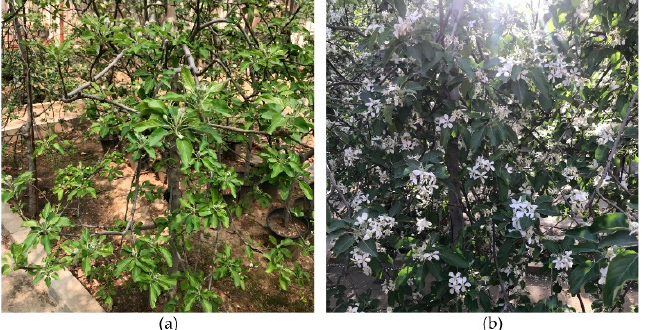
Figure 5. Images of apple flowers in complex natural environments. ( a ) Unclear features of the buds; ( b ) Complex light